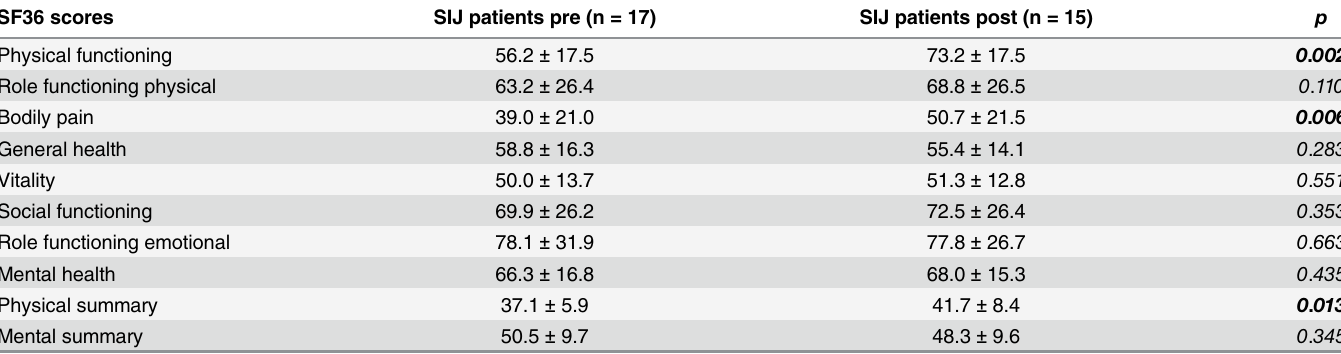
Table 2. Short Form 36 (SF36) transformed scores of patients with sacroiliac joint (SIJ) pain prior to pelvic belt application (pre) and in a six-weeks follow up with pelvic belt application (post). Mean values ± standard deviations are given. SF36